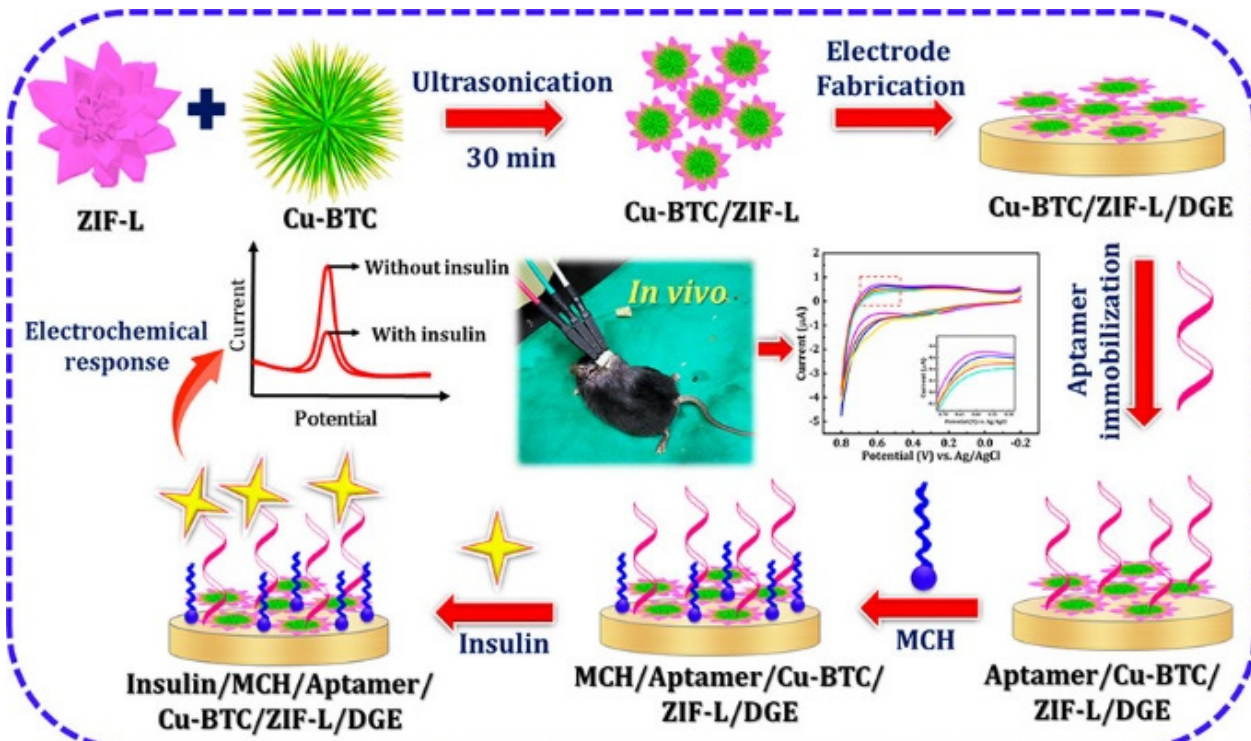
Figure 11. Schematic representation of Cu − BTC/ZIF − L synthesis and its insulin sensing mechanism. Reprinted (adapted) with permission from [96] Copyright {2022} American Chemical Society.